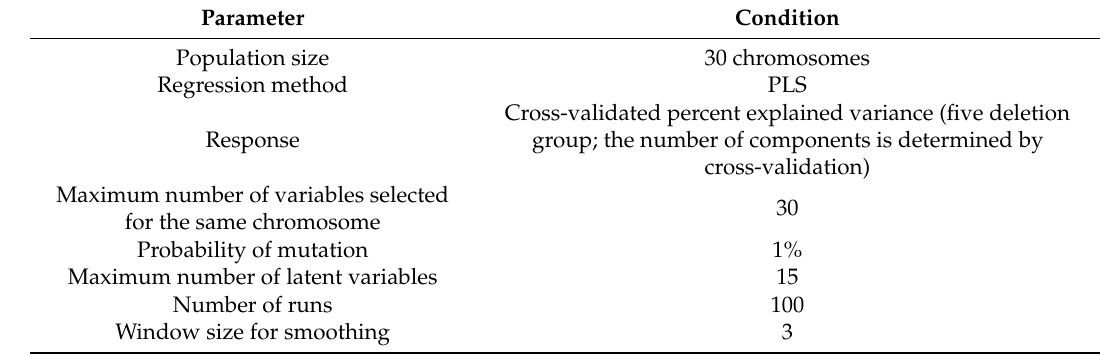
Table 1. Parameter conditions of the genetic algorithms-partial least squares (GA-PLS)